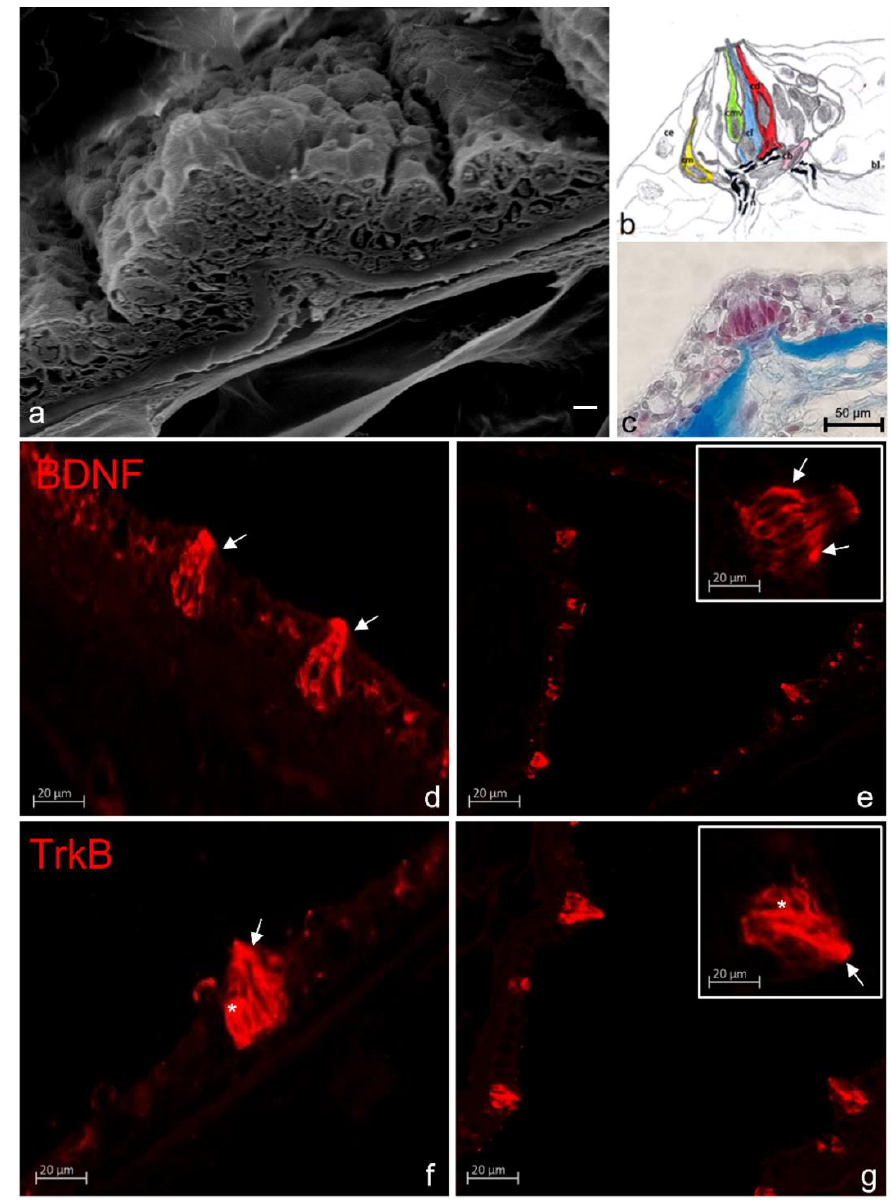
Figure 5. Scanning electron micrograph of zebrafish taste bud ( a ); Schematic drawing of a taste bud ( b ) with light cells (cl), dark cells (cd), light cells with microvilli (cmv), marginal cells (cm), basal cells (cb), nerve (n), and basal layer (bl). Light micrograph of a Masson Trichrome with aniline, blue-stained sagittal section of a taste bud from the oral cavity ( c ); BDNF immunoreactive dark cells (asterisks) in zebrafish cutaneous ( d ); and oral ( e ) taste buds. TrkB immunoreactive dark cells (arrows) and light cells (asterisks) in zebrafish cutaneous ( f ); and oral ( g ) taste buds. Scale bar: 20 µm ( a ). Magnification 40× ( c – g ).